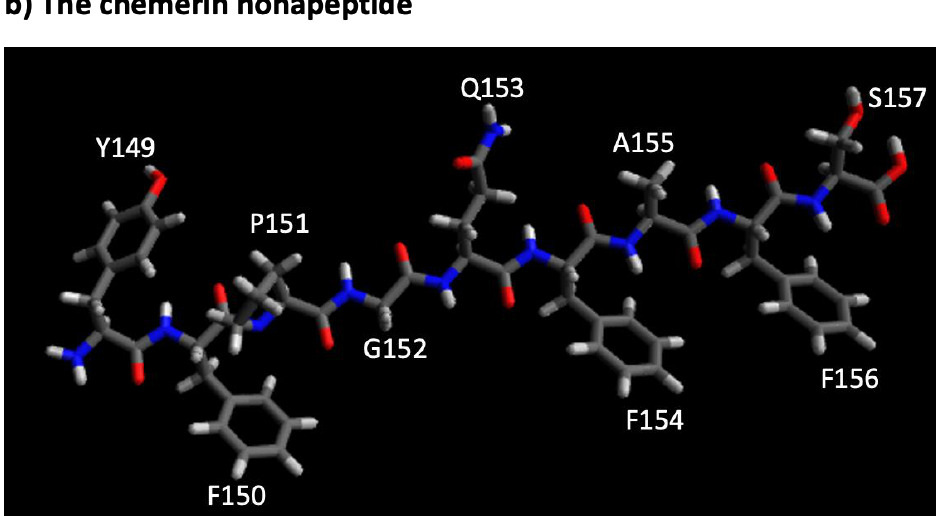
Figure 3. Sequences of mouse and human chemerin and structure of nonapeptide. ( a ) Mouse and human chemerin protein sequences. The arrow marks the site of cleavage by the signal peptidase, and the amino acid residues highlighted in red represent the nonapeptide. ( b ) chemerin nonapeptide.